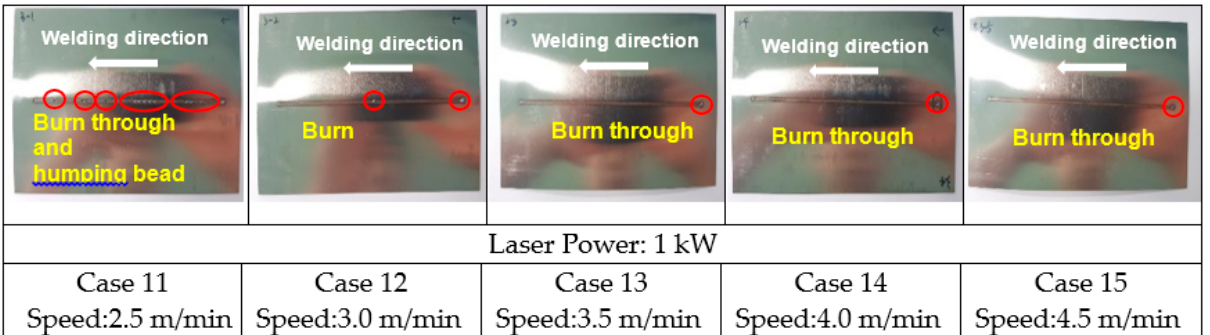
Figure 11. Surface geometry of the third experiment of Lap joint welding.